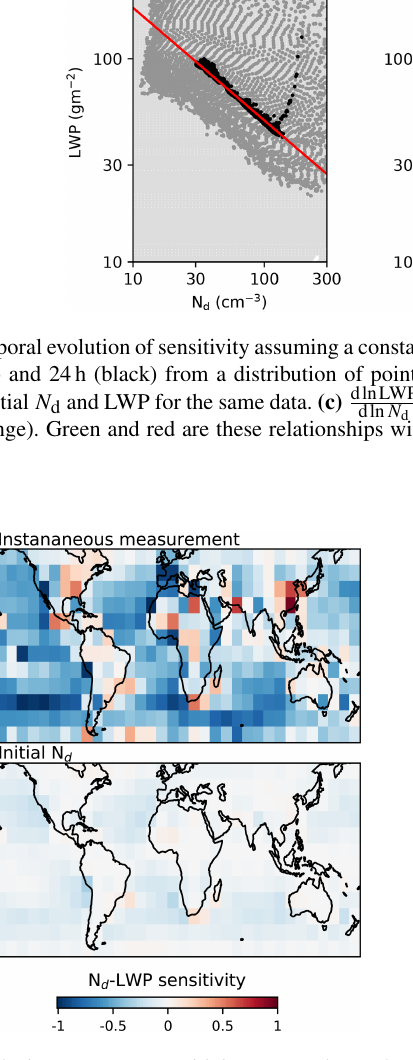
Figure 7. (a) The instantaneous sensitivity averaged over the period 18–24h for each 10 ◦ by 10 ◦ area, and (b) the equivalent data using the initial N d for calculating the